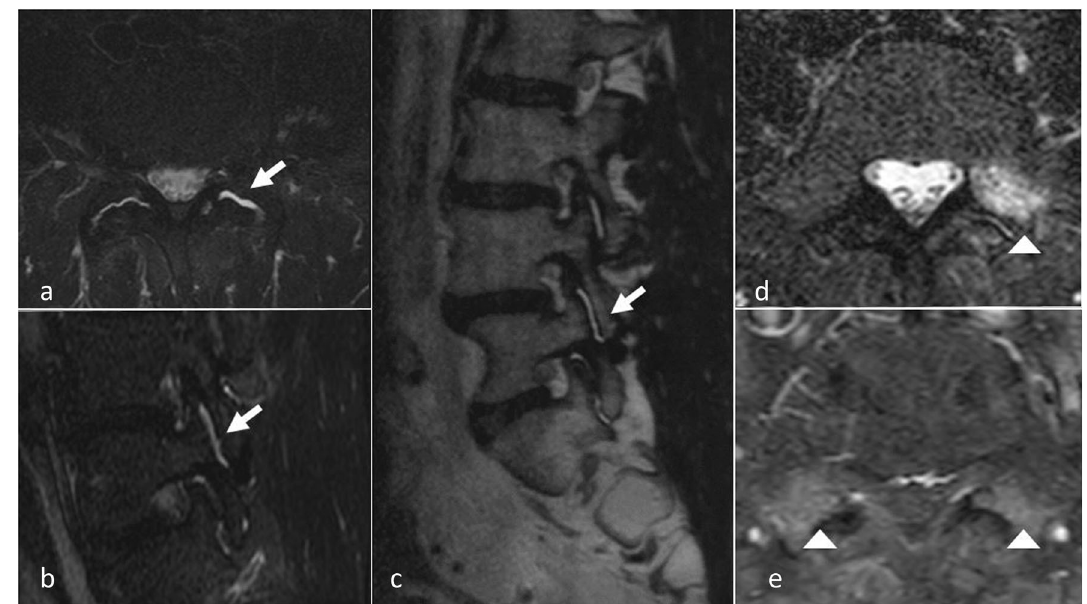
Fig. 6 MRI imaging of facet joints. Active synovial inflammation and intra articular edema: axial and sagittal T2 STIR views ( a , b ) and T2 sagittal view ( c ). T2 STIR and T1 gado axial views ( d , e ): articular process bone